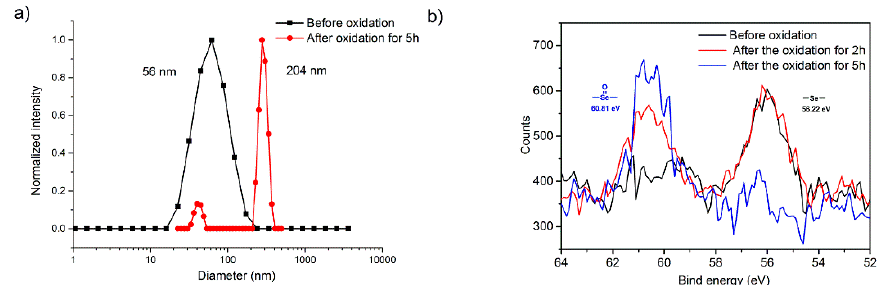
Figure 7. ( a ) DLS results of PS-Se-1- b -PEGMA ( M n,SEC = 3700 g mol − 1 , Ð = 1.11, 1 × 10 − 4 M) assemblies before and after oxidation treatment. ( b ) XPS analysis of the selenide polymer aggregates before and after oxidation treatment.